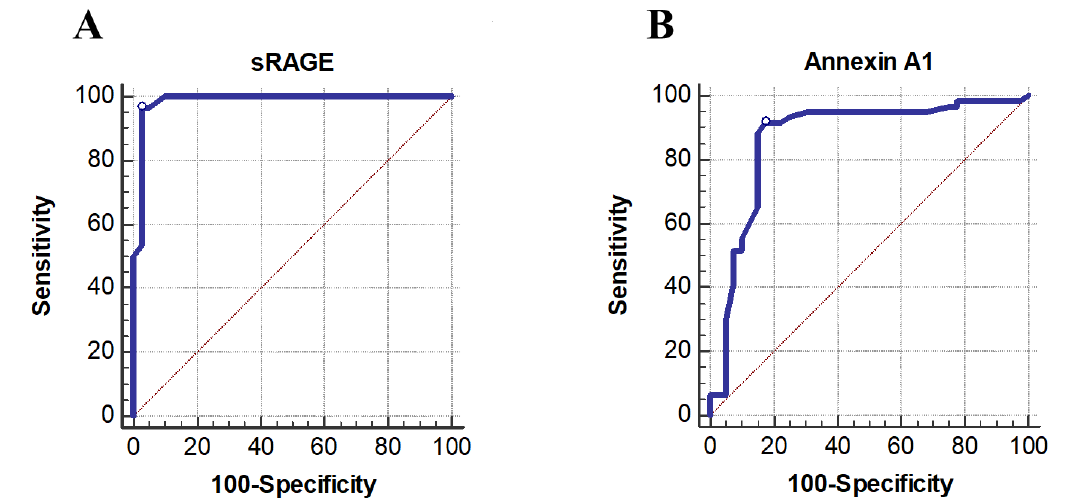
Figure 2. Predictive performances (ROC curves) of ( A ). sRAGE and ( B ). Annexin A1serum level for discrimination between COPD and control groups. Abbreviations: ROC curve, receiver operating characteristic curve; sRAGE, soluble receptor for advanced glycation end products.